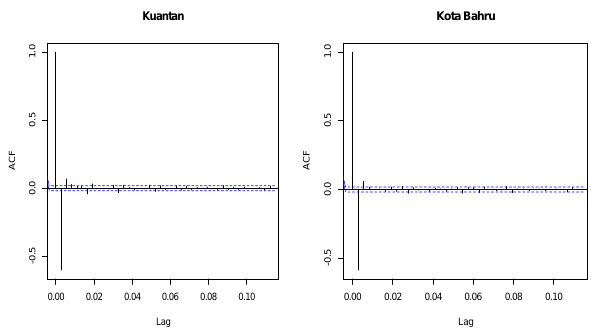
Fig. 4. Autocorrelation functions of the first difference series